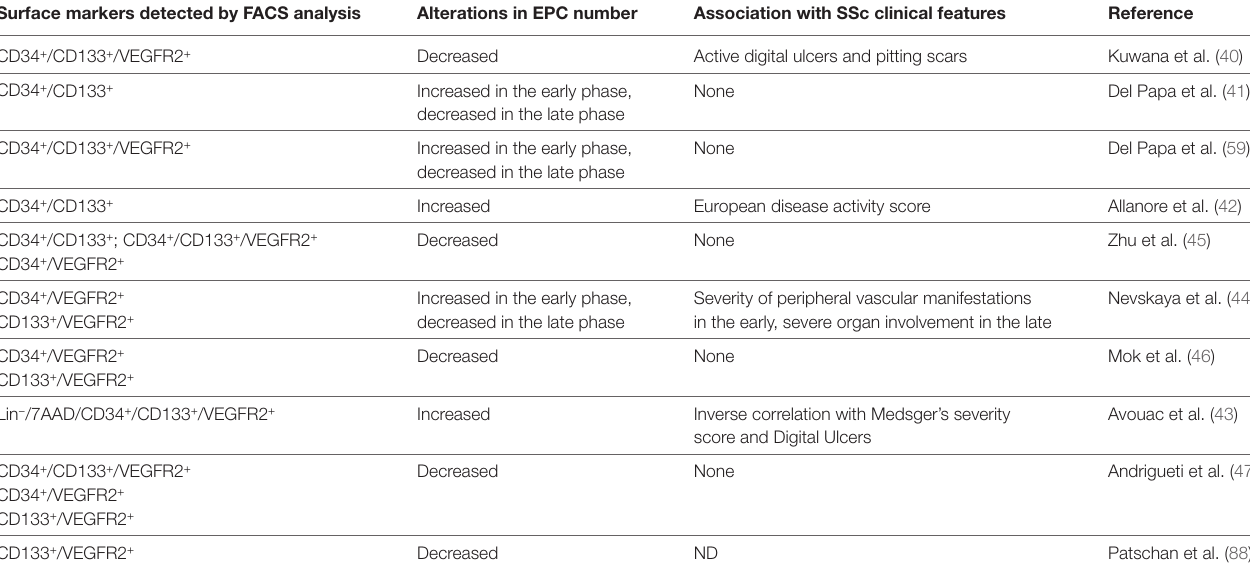
TABLe 1 | Circulating EPCs detected in systemic sclerosis